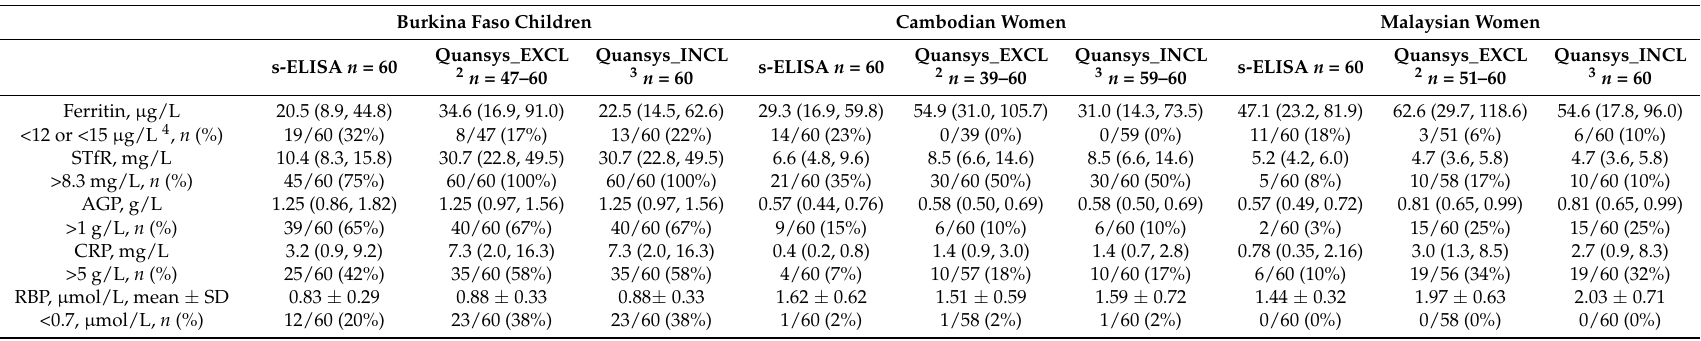
Table 3. Nutritional biomarkers and deficiency prevalence of the women and children based on s-ELISA and Quansys measurements both within and outside of the limit of detection (LOD) range 1